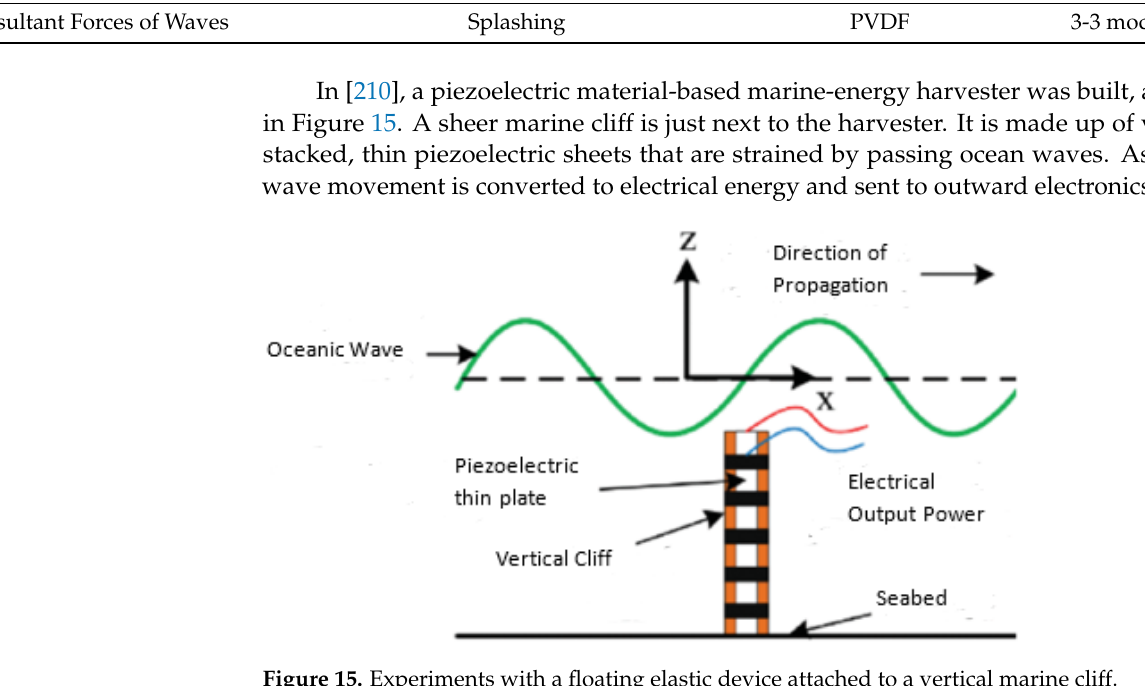
Figure 15. Experiments with a floating elastic device attached to a vertical marine